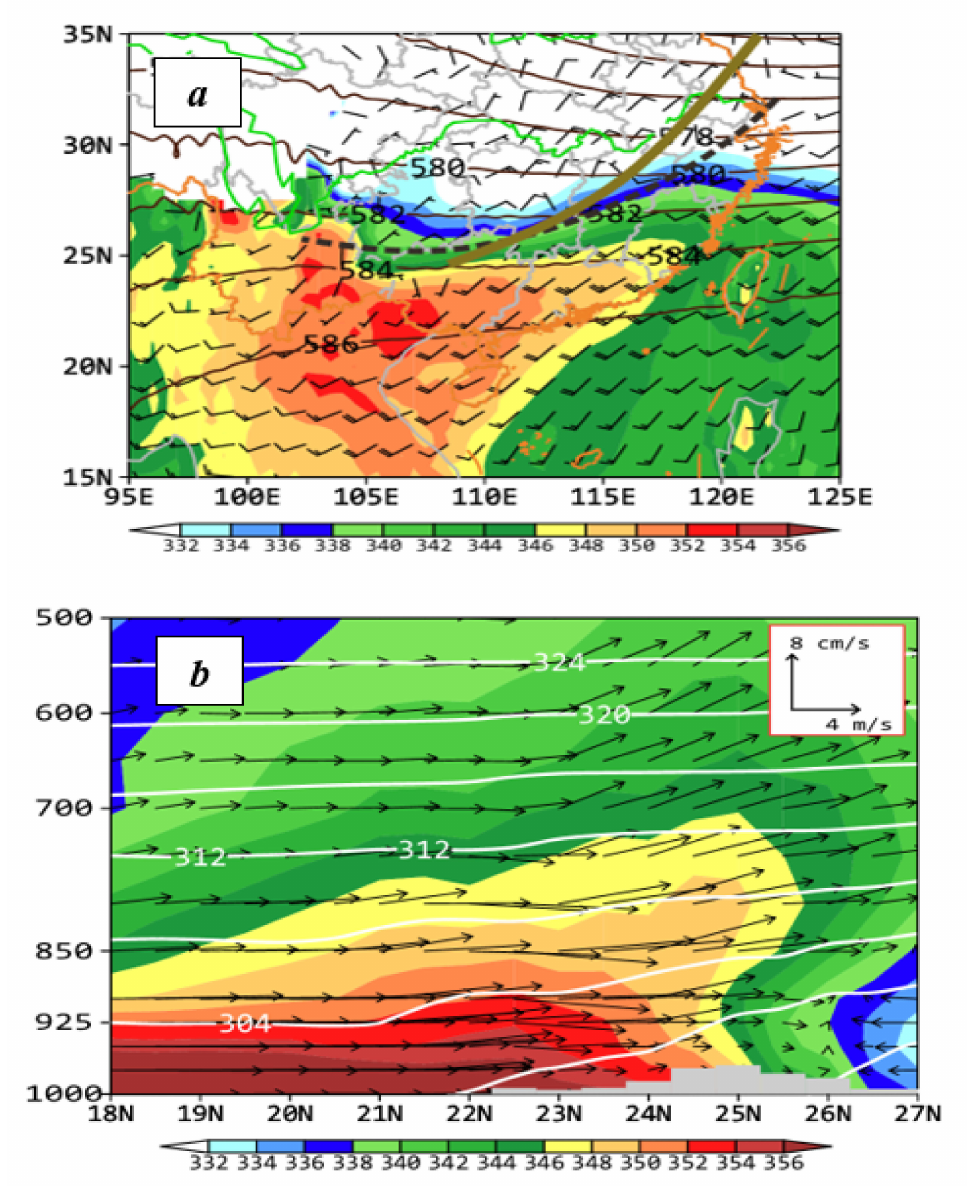
Figure 5. Composite analysis of the 21 PSF-type WSHR events from the NCEP’s 0800 BST GFS data: ( a ) Geostrophic height (contoured at 20-m intervals) at 500 hPa, horizontal wind barbs (a full barb is 4 m s − 1 ) and equivalent potential temperature (shaded, θ e , K ) at 850 hPa; and ( b ) South-north vertical cross section of potential temperature (contoured at 4-K intervals) and θ e (shaded), superimposed with in-plane flow vectors, along 112 ◦ E (near Yangjiang with the top HR amount) during the pre-summer months of 2008–2014. Dashed lines and the green thick line in ( a ) denote a shearline and roughly a trough axis, respectively. Grey shadings in ( b ) denote